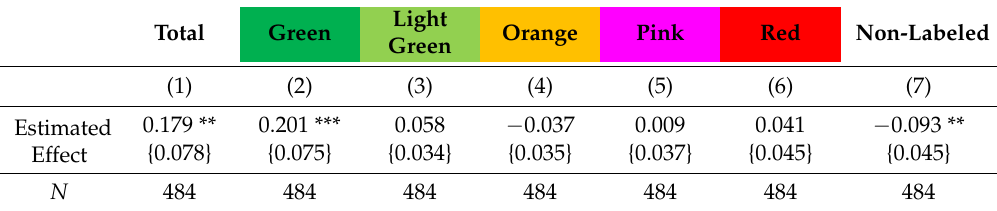
Table 2. Unconditional effect of providing Nutri-Score Label information on total expenditure and expenditure by color. Intention to treat (ITT) estimates.